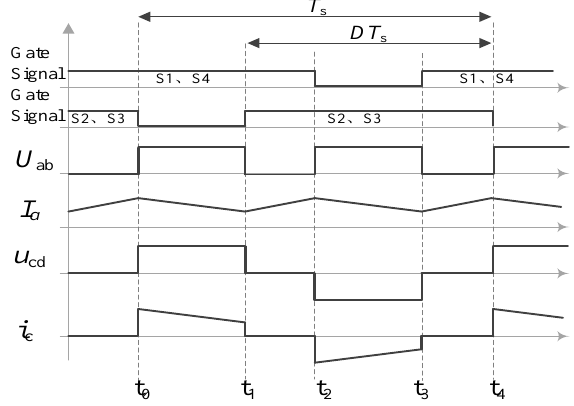
Figure 5. Steady-state operating waveforms of full-bridge isolated DC/DC converter.